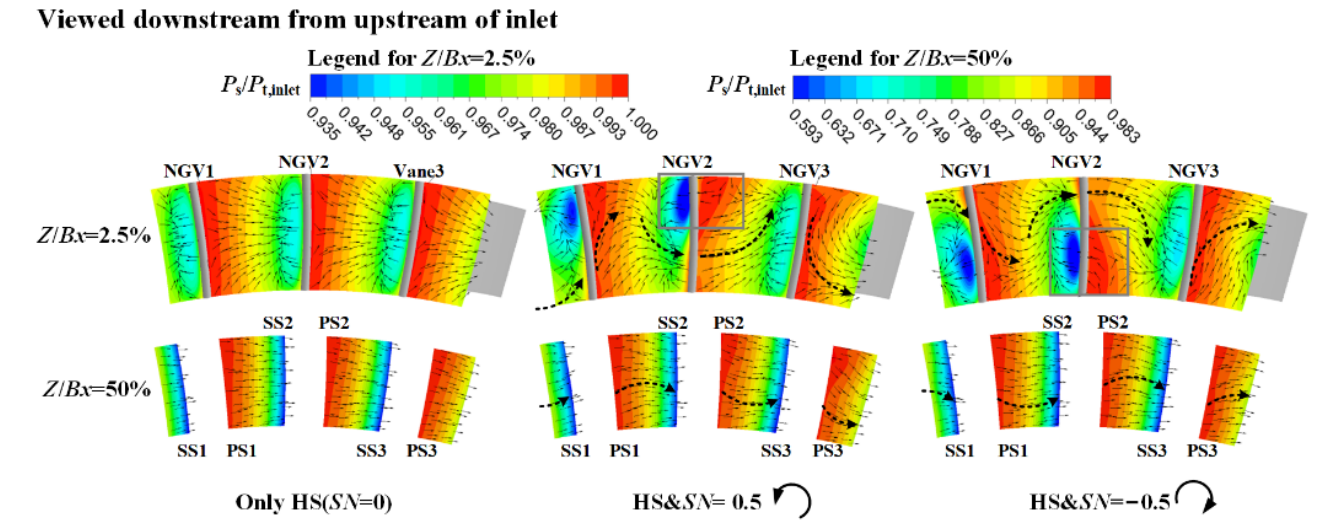
Figure 13. Pressure contour and vectors at the planes of Z / Bx = 2.5% and Z / Bx = 50%.